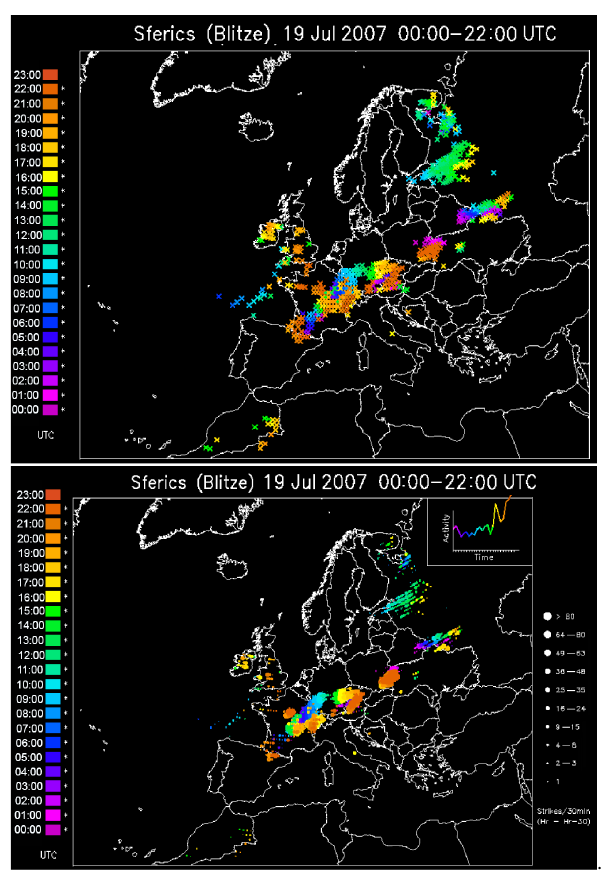
Figure 4. (top panel) Lightning activity from 00:00 to 22:00UTC on 19 July 2007 over Europe. (bottom panel) Lightning flash oc- currence in flashes per 30min for the same time interval. The colour code indicates the time of flash detection. Source: www.